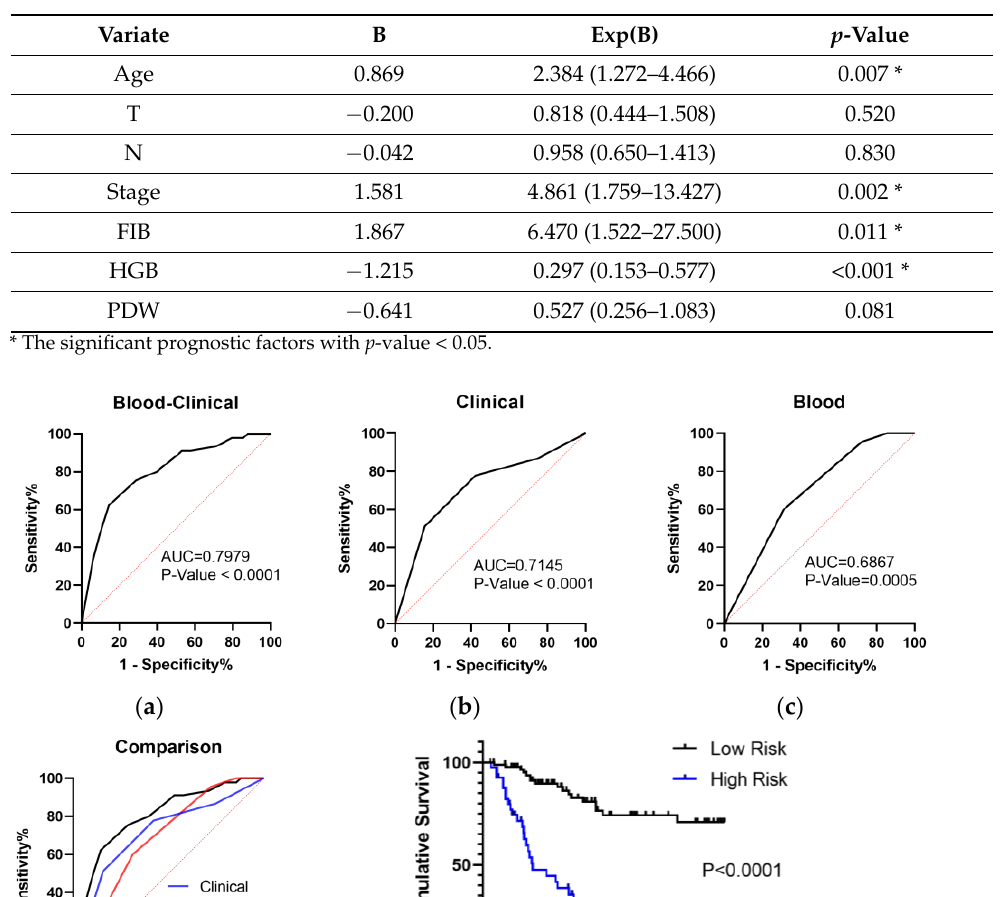
8 Figure 5. K-M analysis of demographic indicators to predict OS ( p -value < 0.1) in LSCC. ( a ) K-M analysis of age for OS with the log-rank test. ( b ) K-M analysis of N stage for OS with the log-rank test. ( c ) K-M analysis of T stage for OS with the log-rank test. ( d ) K-M analysis of clinical stage for OS with the log-rank test. 3.2.3. Multivariate COX Analysis to Select Independent Prognostic Factors for Advanced LSCC Patients The multivariate COX analysis included the selected peripheral blood parameters and clinical factors (Table 2). The scores of the three peripheral blood parameters were defined as 1 value ( ≥cutoff ) or 0 value (<cutoff) according to the Youden Index, and the score of age was defined as 1 value (< 60) or 0 value (≥60). T, N, and clinical stages were divided into ranked variables according to the international criteria. The results showed